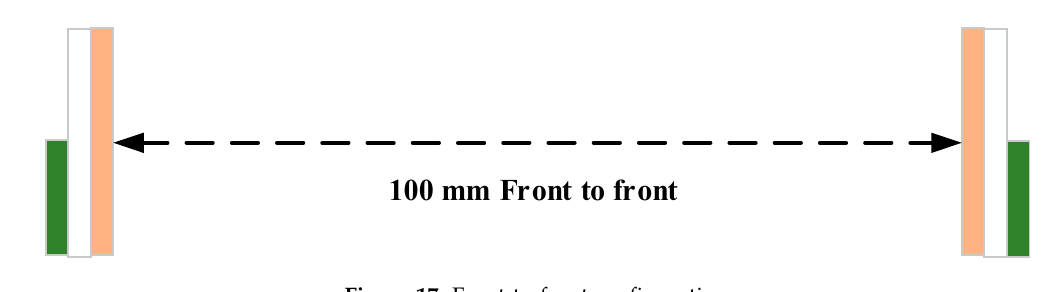
Figure 17. Front-to-front configuration.